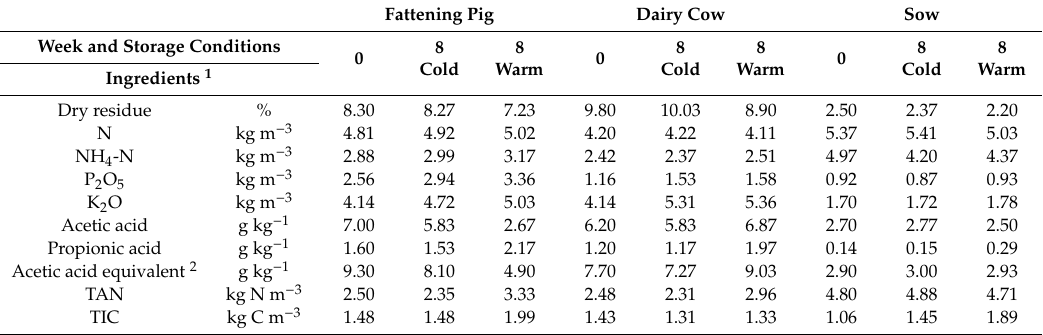
Table 1. Characteristics of fattening pig, dairy cow and sow slurry (fresh material) in week 0 and 8